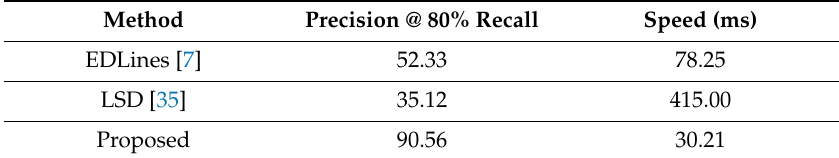
Performance comparison between proposed power line detection algorithm and state-of-the-art schemes.